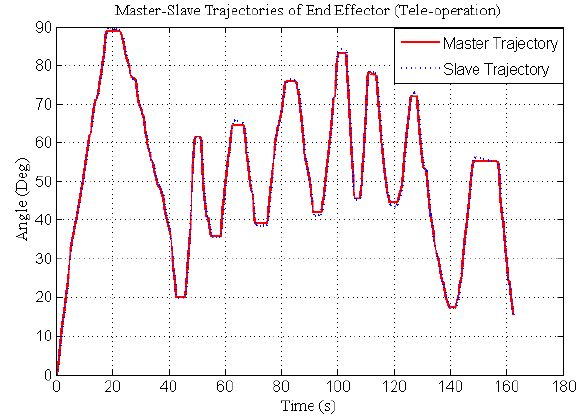
Figure 10. Master / slave trajectories for end e ff Figure 10. Master/slave trajectories for end effectors.